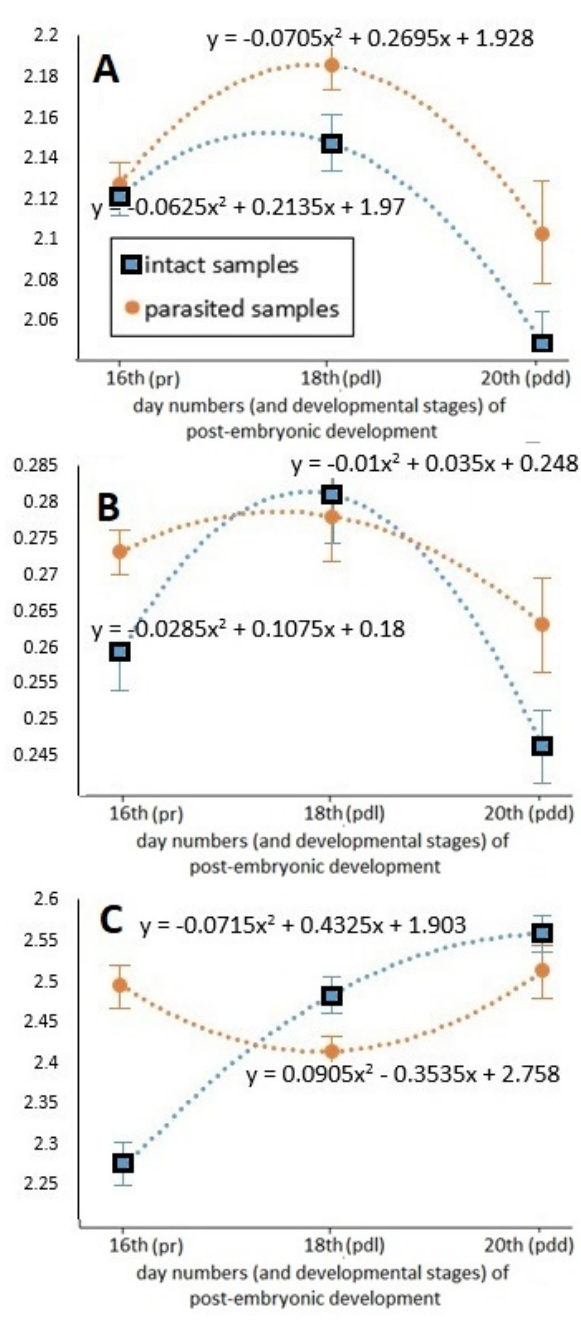
Figure 5. Tendency of the calculated body part ratios (mean ± SE) as a function of the different times in post-embryonic honey bee development. ( A ): total-body–abdomen ratio; ( B ): head–abdomen ratio; ( C ): total-body–thorax ratio. pr, pdl, pdd: ontogenetic stages of worker bee development, following [26,31]; R 2 = uniformly